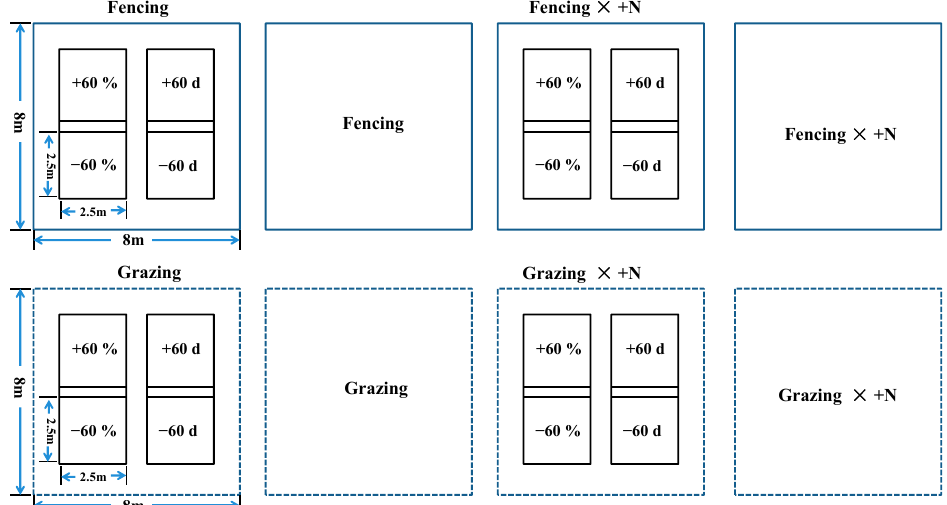
Figure 3. Layout of the test plots.